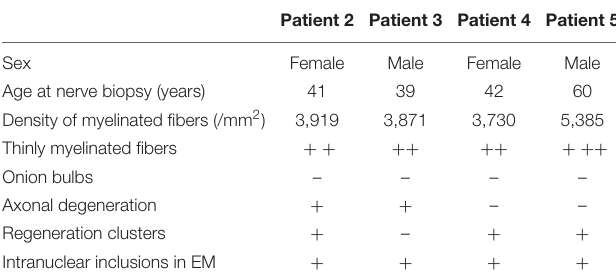
TABLE 3 | Pathological findings of patients with abnormal GGC repeat